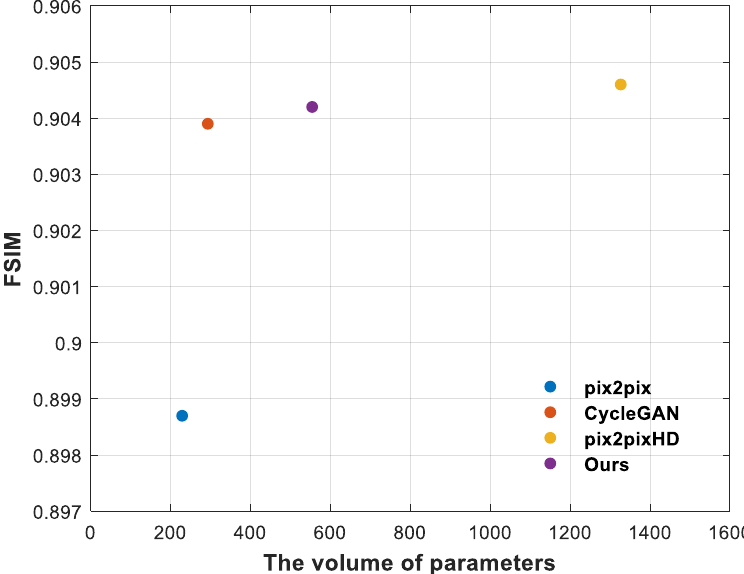
Figure 12. Comparison of the results generated by our method and SOTA methods. The ordinate of the graph represents the normalized FSIM value, and the abscissa represents the parameter size (Mbyte) of the model. The comparison of the four methods is represented by a scatter diagram. The closer the scatter points are to the y -axis +∞, the better the overall cost performance of the model.